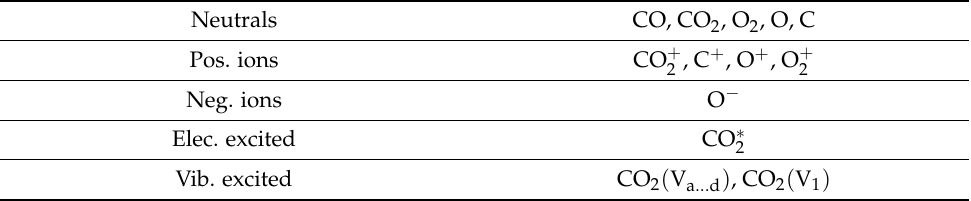
Table 2. Species considered in the